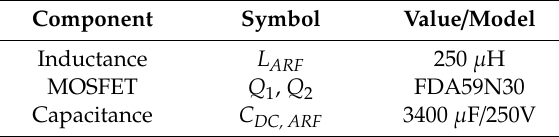
Figure 11. Experimental platform of a 500 W single-phase DC/AC conversion integrated with ARF. Table 1. Component parameters of the ARF circuit.